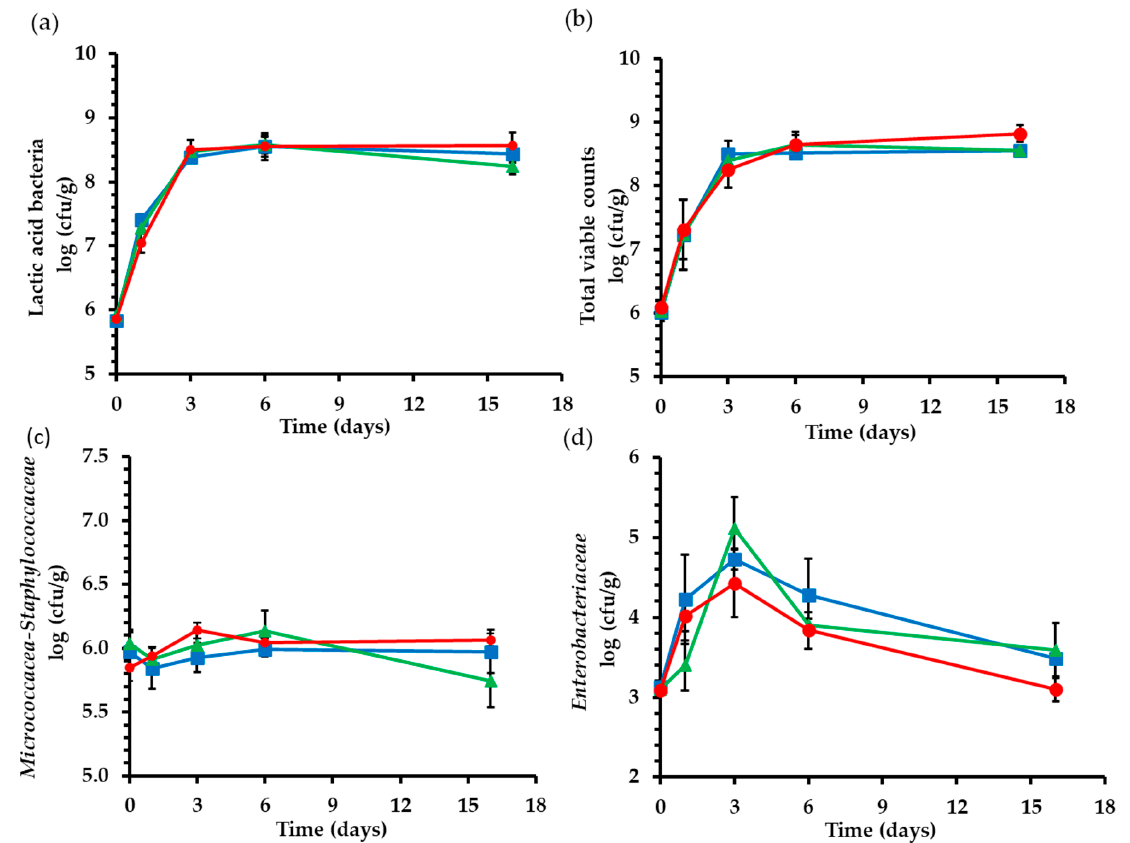
Figure 3. Lactic acid bacteria ( a ), Total viable counts ( b ), Micrococcaceae-Staphylococcaceae ( c ), and Enterobacteriaceae ( d ) counts during fermentation and ripening of fermented sausages. ( ■ ) Control: 18% pork backfat; ( ▲ ) SB60: 9% pork backfat and 9% B60 bigel; ( ● ) SB80: 9% pork backfat and 9% B80 bigel.